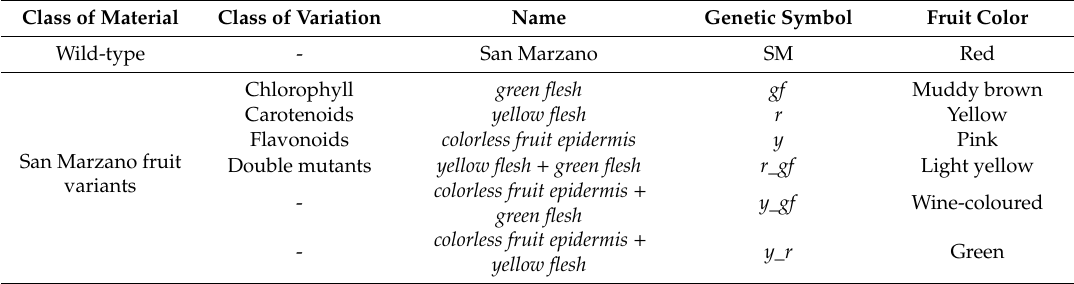
Table 1. Extended names, genetic symbols and description of the berry color of the seven studied genotypes, including San Marzano (SM), three single mutant and their respective double mutants. Class of Material Class of